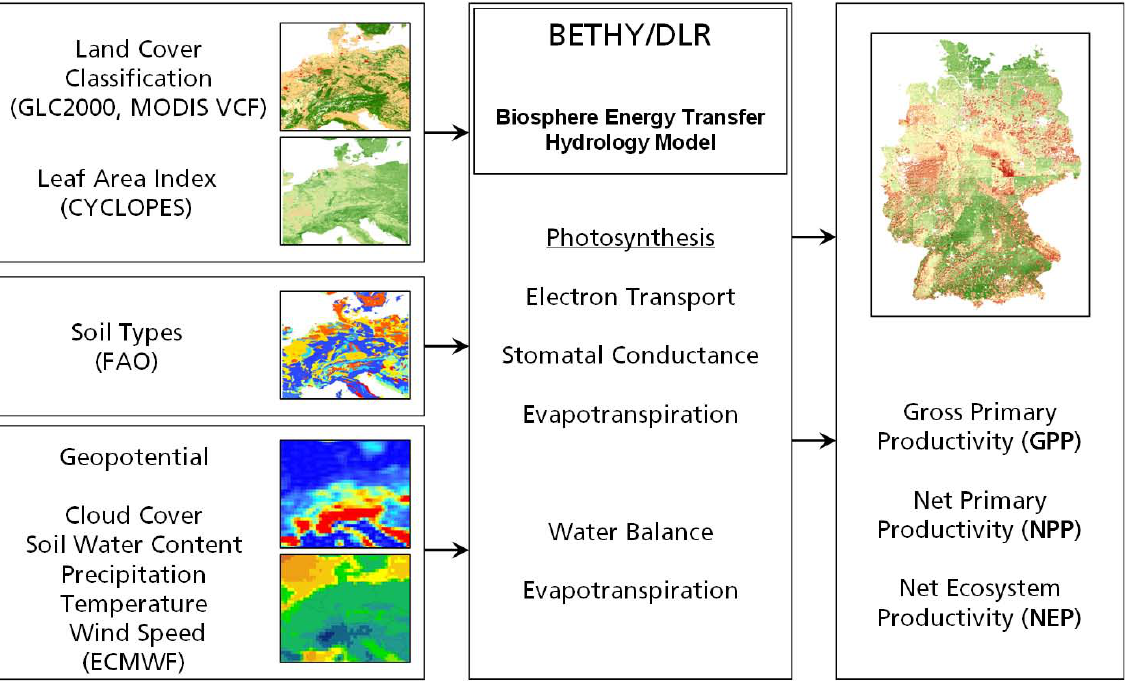
Fig. 1. Model overview for BETHY/DLR. Left: input data, middle: internal model processes, right: outputs.